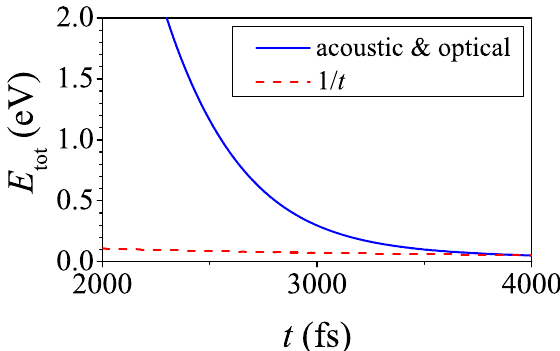
Figure 5. The time evolution of the total energy is shown. The dashed line represents the energy relaxation, which is proportional to t − 1 . The total energy is referenced from that in the completely Fermi degenerated state (CFDS). Adapted with the permission from [11], copyright Journal of the Physical Society of Japan, 2015.